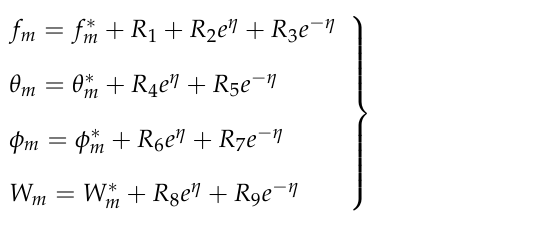
 the curve of ''(0) f ( b ) Figure 2. Plots of ( a ) Figure 2. Plots of ( a ) (cid:125) f the curve of f (cid:48)(cid:48) ( 0 ) ( b ) (cid:125) θ the curve of θ (cid:48) ( 0 ) ( c ) (cid:125) φ the curve of φ (cid:48) ( 0 ) ( d ) (cid:125) w f '(0) φ ( d )  the curve of W'(0) . the curve of W (cid:48) ( 0 ) w